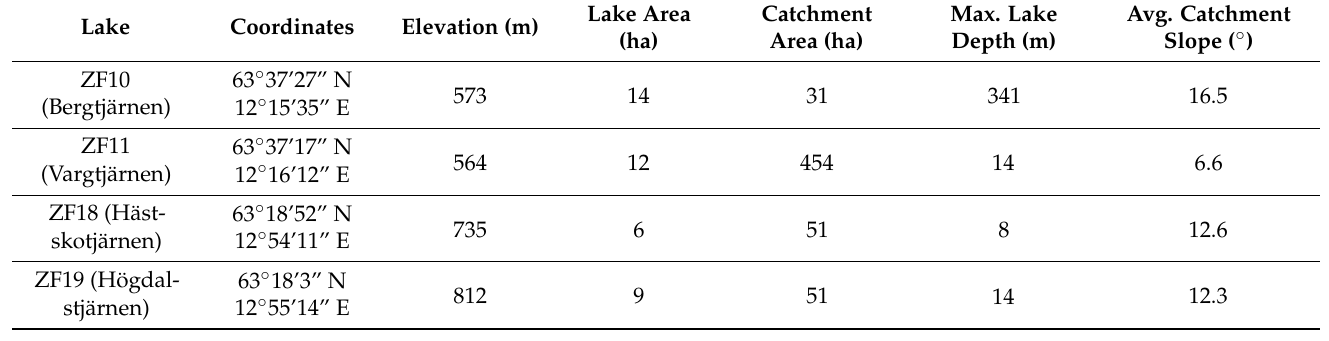
Table 1. Location and characteristics of the study sites.